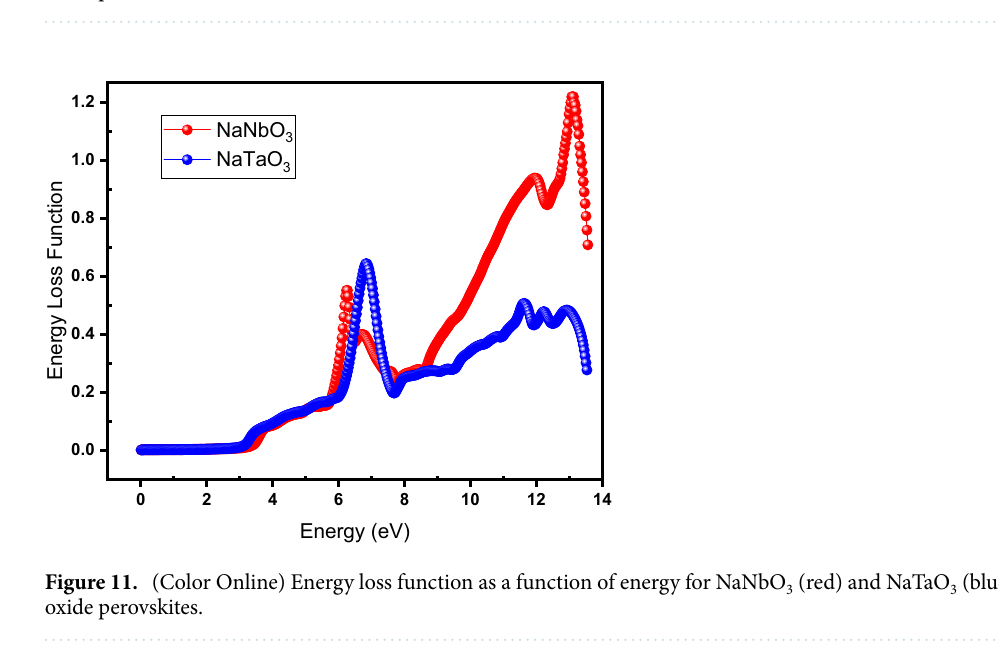
Figure 10 exhibits the extinction coefficient for both NaNbO 3 and NaTaO 3 , represented by red- and blue- colored data, respectively, where it is zero for the photon energy ranging from 0 to 3.0 eV and starts increasing with further increasing energy. The extinction coefficient gets to its maximum value at 5.87 and 6.17 eV for NaNbO 3 and NaTaO 3 , respectively. This decreases at higher energy followed by fluctuations with increasing energy beyond 7.5 eV. Energy‑loss function. Describing the intra-band, inter-band, and plasmon interdependencies, the energy- loss function for both NaNbO 3 and NaTaO 3 is shown in Fig. 11, represented by red and blue data points, respec- tively. The energy-loss function also describes the energy lost by an electron while moving fast through a mate- rial. Figure 11 shows that the energy-loss function for both materials is zero for the energy of the photon ranging from 0 to 3.18 eV and starts increasing with increasing photon energy while peaking at 6.24 and 6.86 eV for NaNbO 3 and NaTaO 3, respectively. At higher energies, i.e., beyond 7.75 eV, energy loss hikes up for NaNbO 3 while there is no significant variation in it for NaTaO 3 .